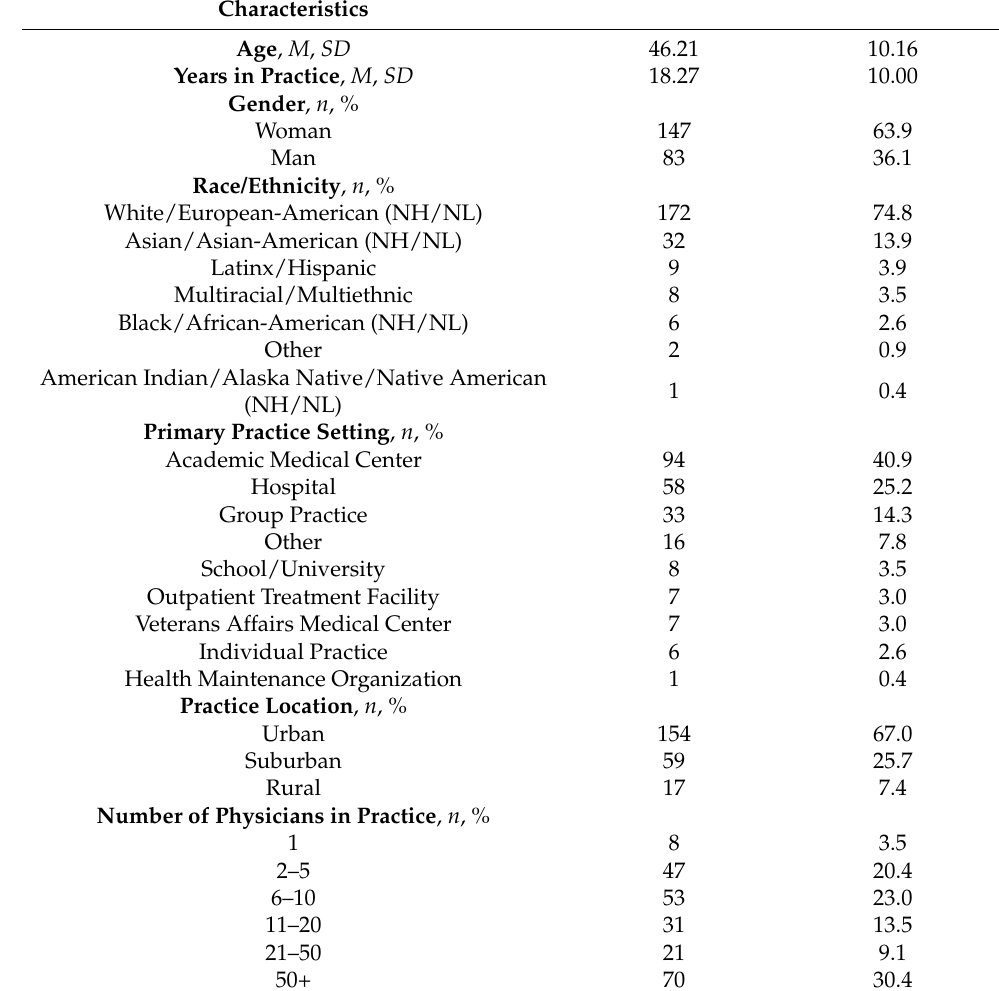
Table 1. Summary of Participant